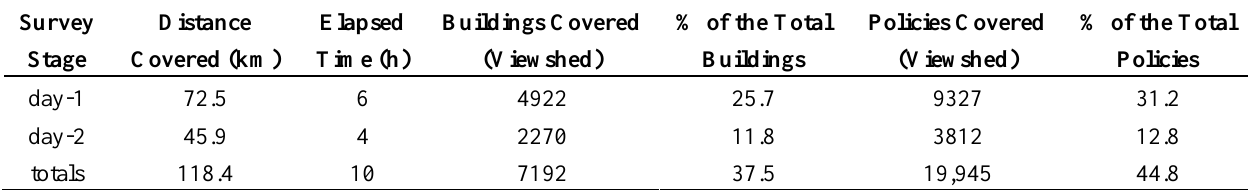
Table 4. Summary of the two-day survey conducted in Besiktas.